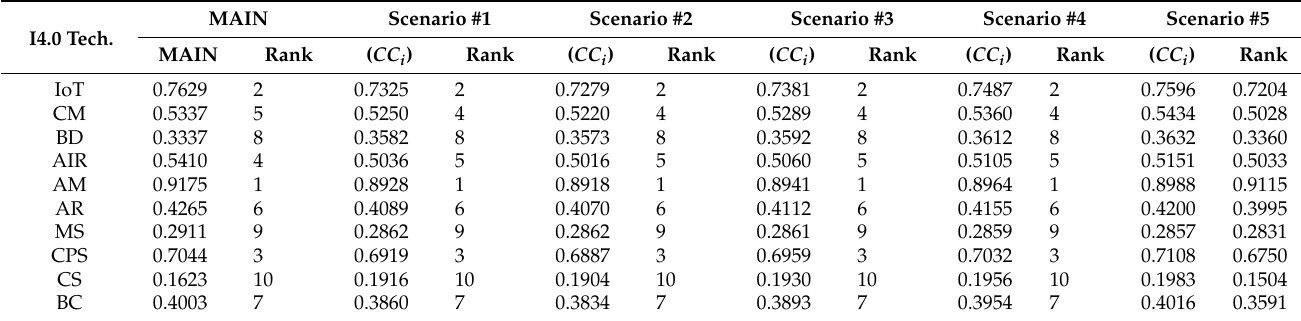
Table 10. Results of the sensitivity